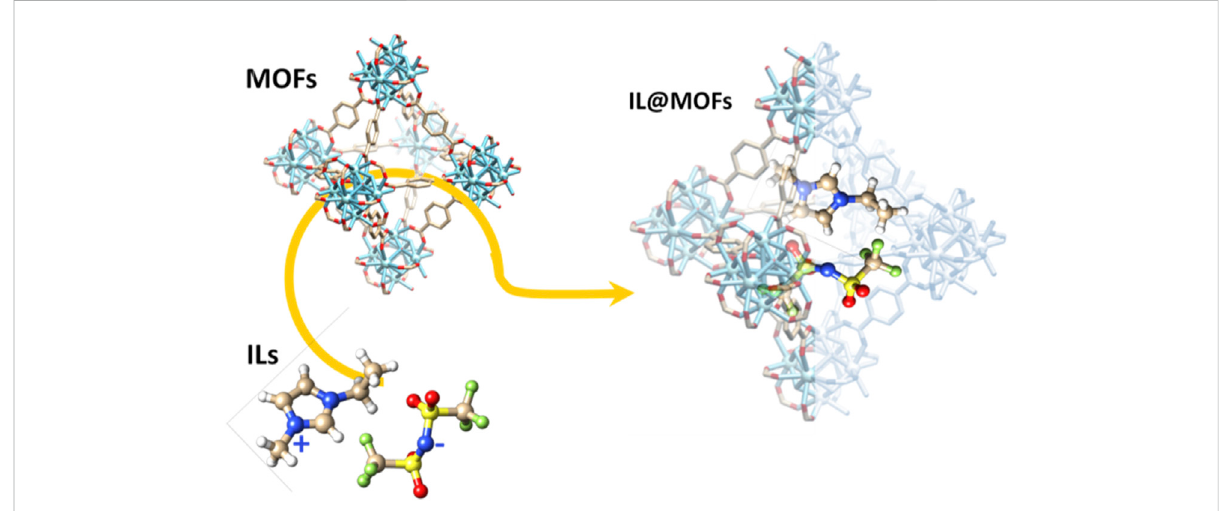
FIGURE 2 Representation of an illustrative image of the MOFs, ionic liquids and the possible combination of both into IL@MOF type composite materials.